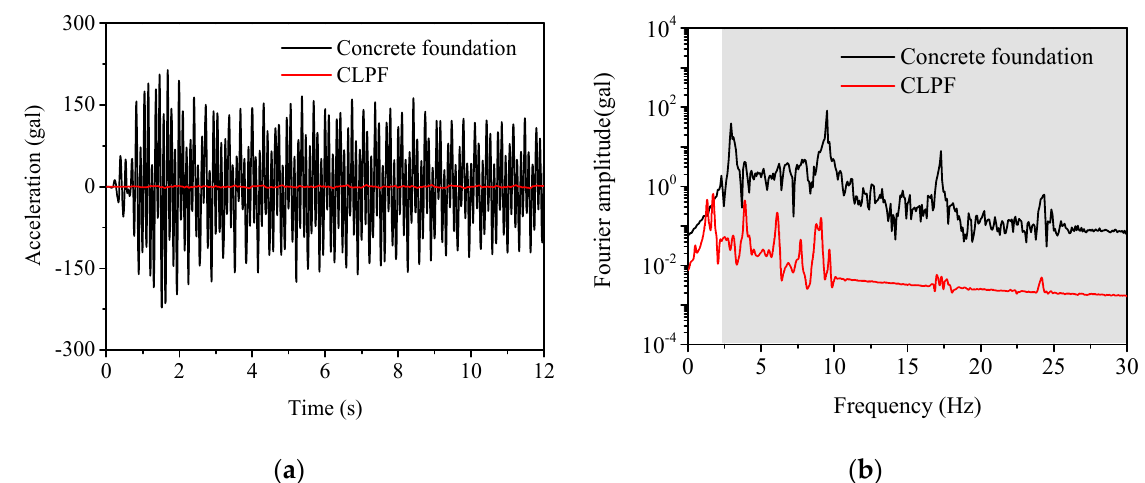
Figure 17. ( a ) Acceleration of node P under Whittier Narrows–02 seismic wave and ( b ) its Fourier spectra.